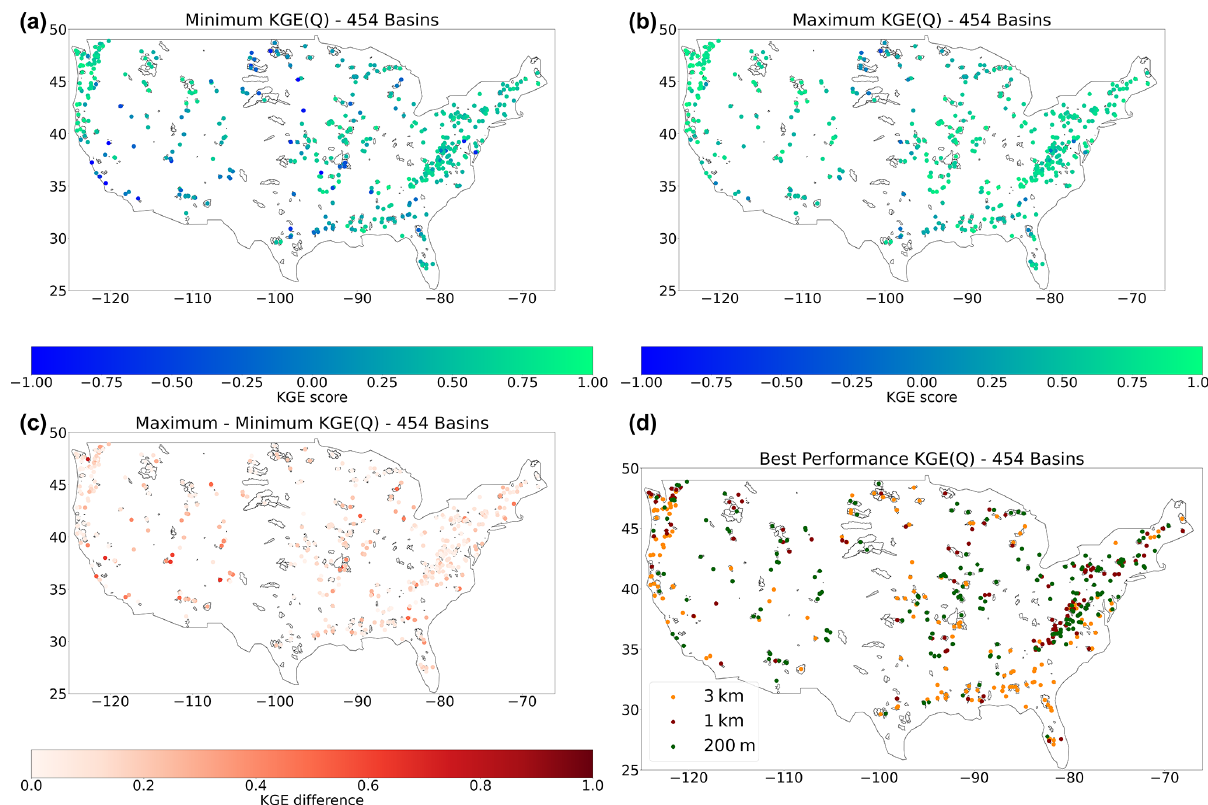
Figure 10. Evaluation period results. (a) Minimum KGE score of the model instances. (b) Maximum KGE score of the model instances. (c) The difference between minimum and maximum KGE scores. (d) Best performing model instance based on KGE score for the evaluation period with 3km in orange, 1km in red, and 200m in